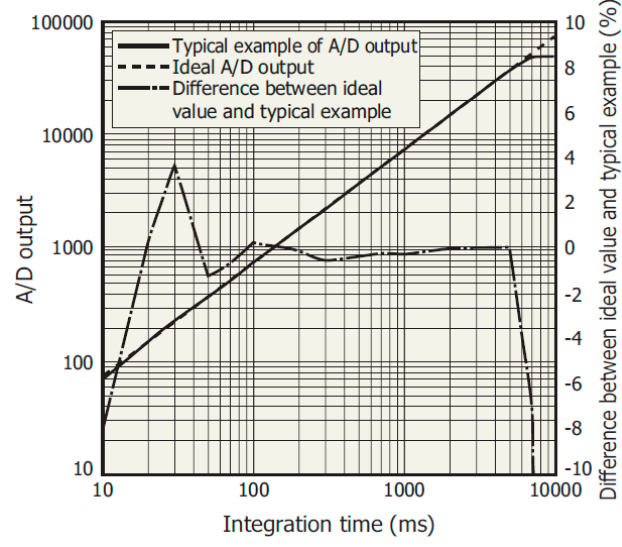
Figure 9. MEMS C12666CA linearity [23].